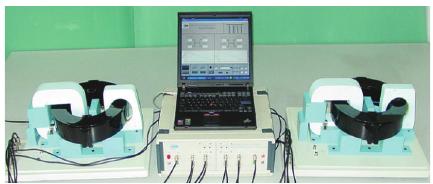
Figure 4: A novel noncontact electrical resistivity instrument.